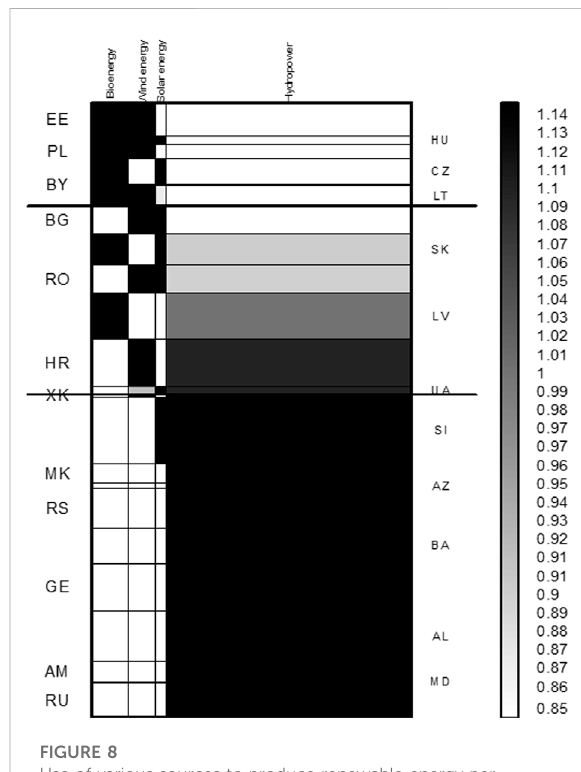
FIGURE 8 Use of various sources to produce renewable energy per capita in countries of Central and Eastern Europe in 2011 –